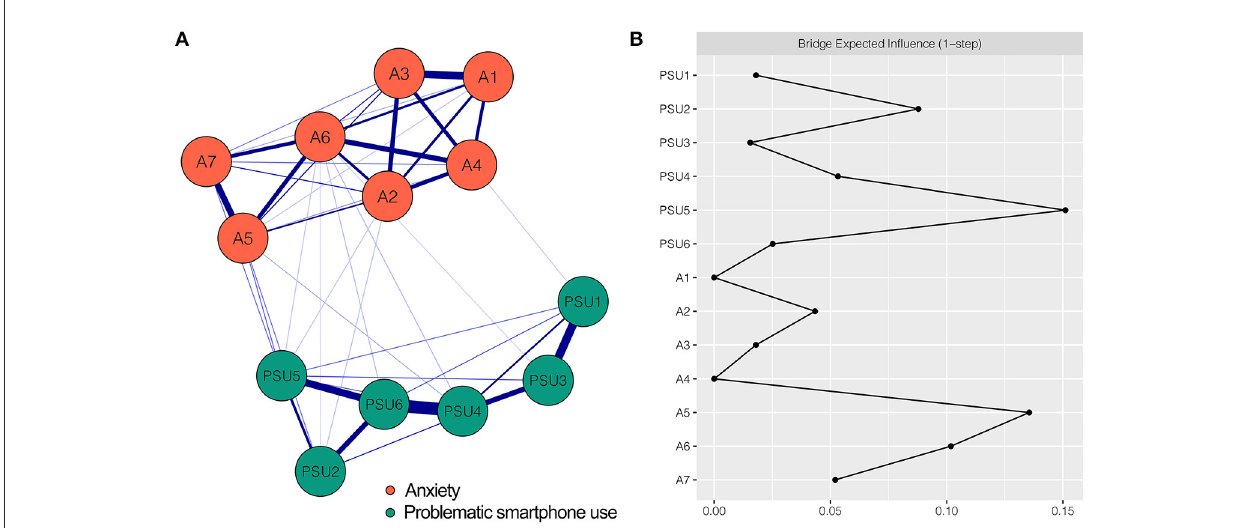
FIGURE1 Network structure of PSU-anxiety variables and bridge expected influence for each node. (A) The PSU-anxiety network. Blue edges represent positive correlations. A thicker edge reflects higher correlation between the nodes. (B) The bridge expected influence of each node in the network (raw value). PSU1, Salience; PSU2, Conflict; PSU3, Mood modification; PSU4, Tolerance; PSU5, Withdrawal; PSU6, Relapse; A1, Nervousness or anxiety; A2, Uncontrollable worry; A3, Worry too much; A4, Trouble relaxing; A5, Restlessness; A6, Irritable; A7, Afraid something will